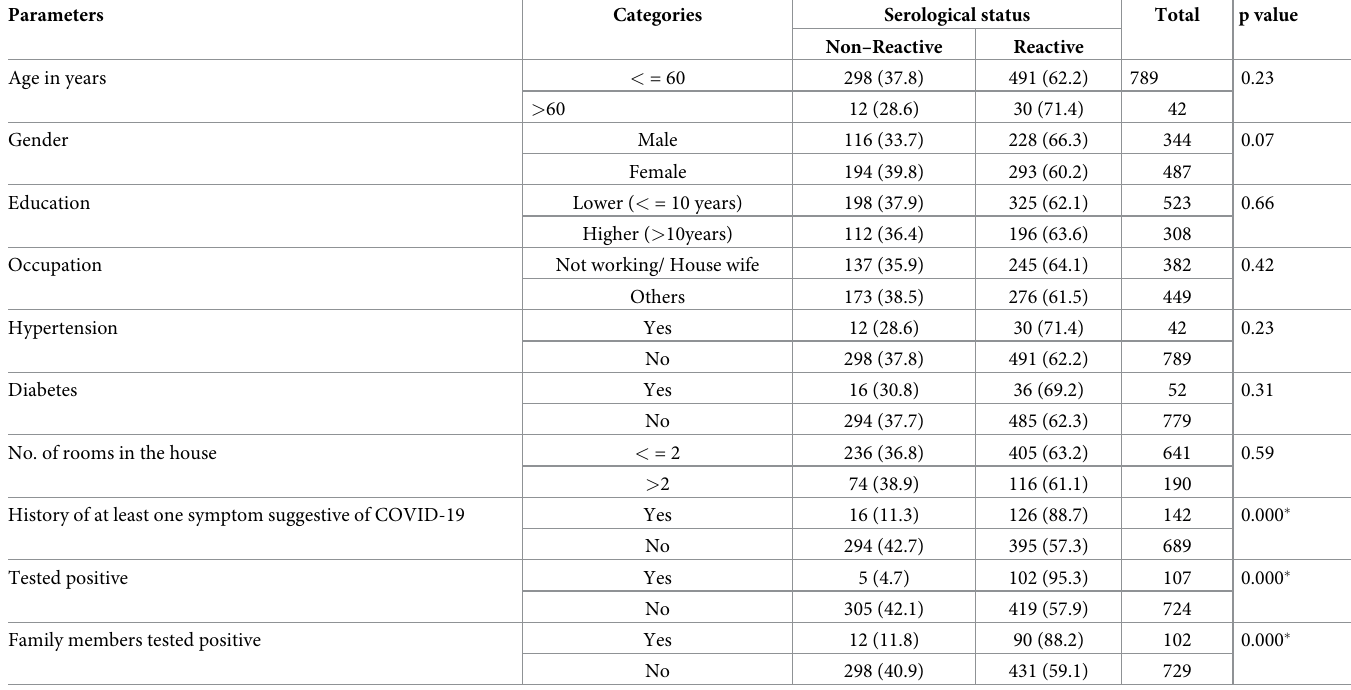
Table 3. Factors associated with